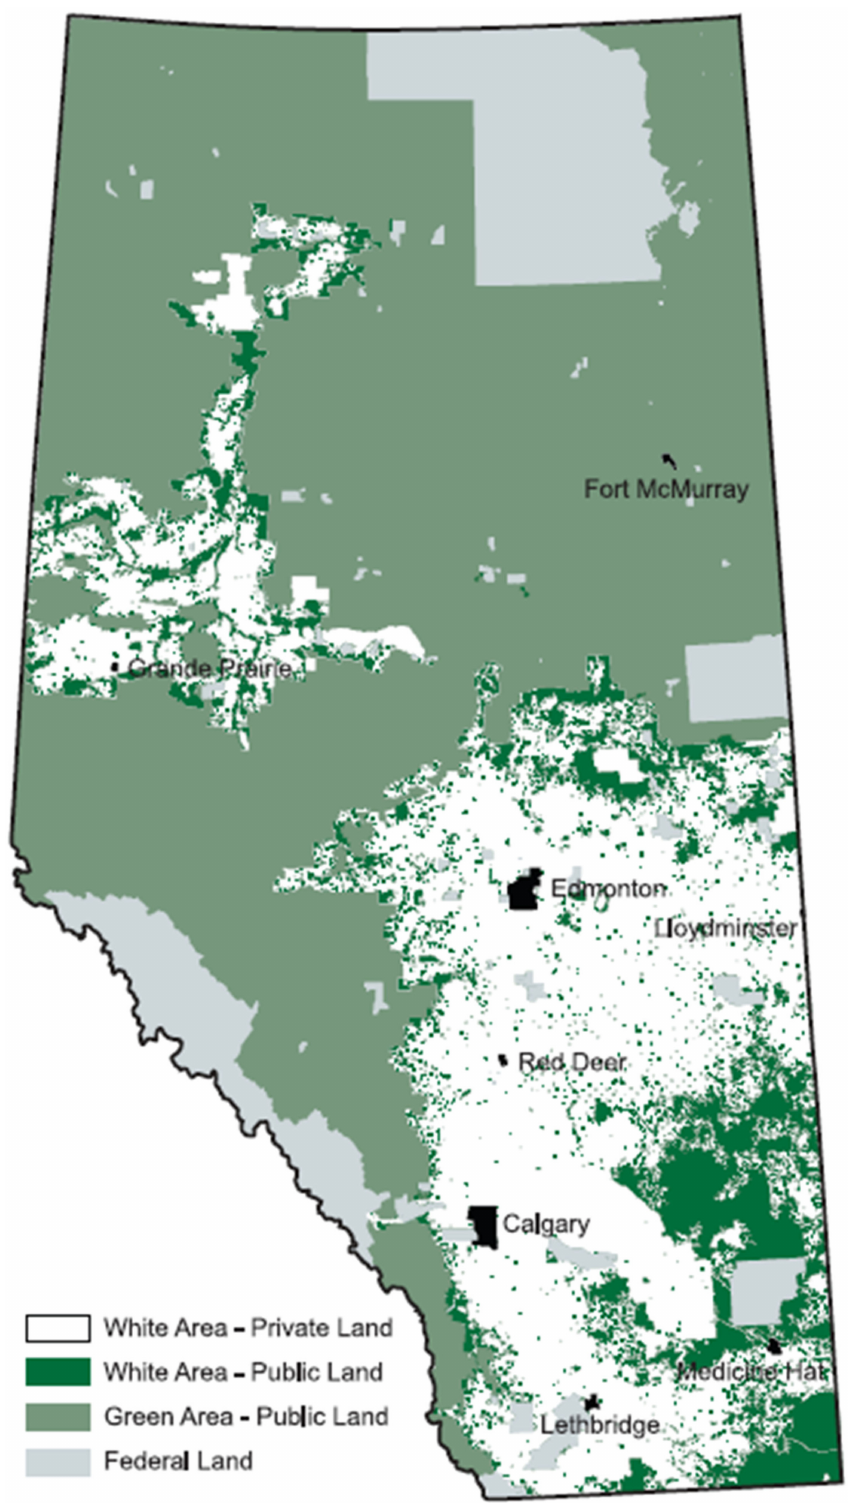
Figure 3. Alberta’s Land segregated as Green Area, White Area (Public and Private) and Federal Land in Land-use Framework [112]. Black area is the city